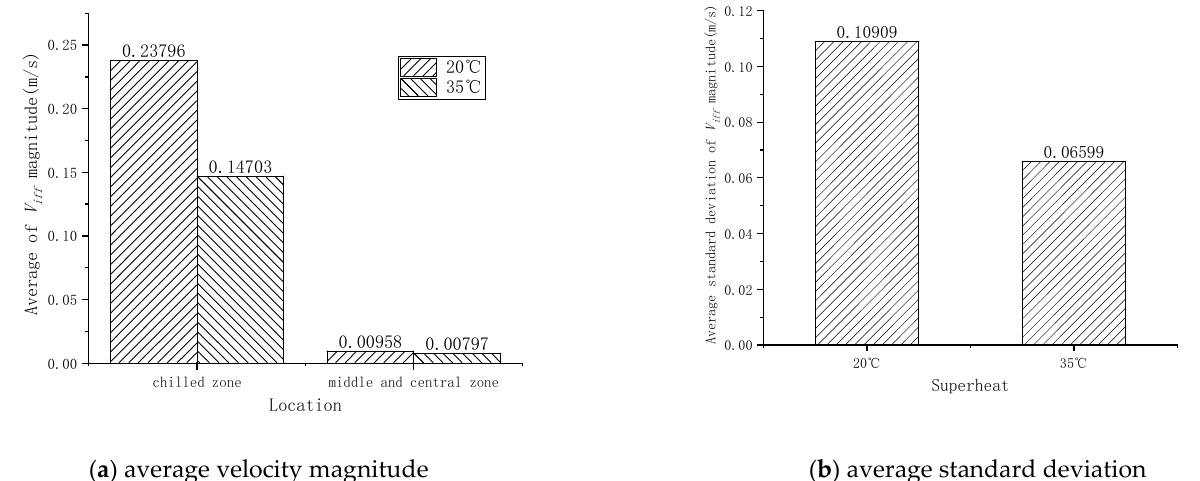
Figure 18. Increasing proportion of average magnitude of interdendritic fluid flow velocity the inner curve side compared to that of outer curve side at different zones.